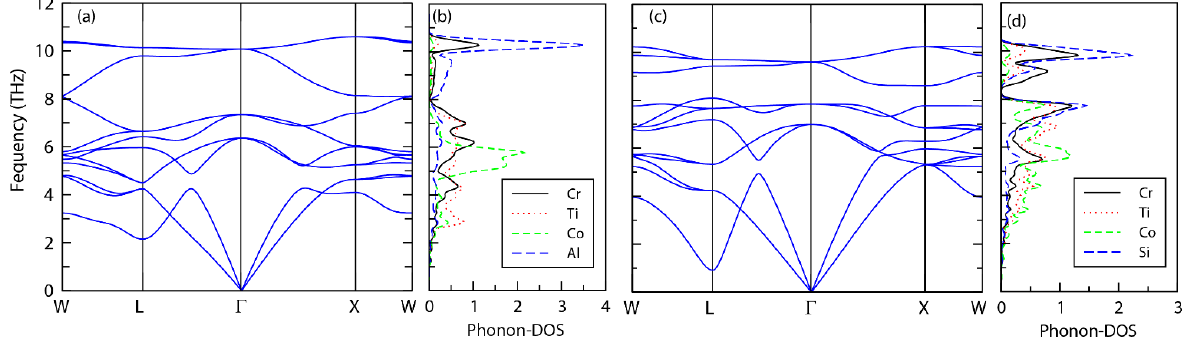
Figure 2. Phonon dispersion relations of ( a ) CrTiCoAl and ( c ) CrTiCoSi and Projected phonon density of states for ( b ) CrTiCoAl and ( d ) CrTiCoSi.